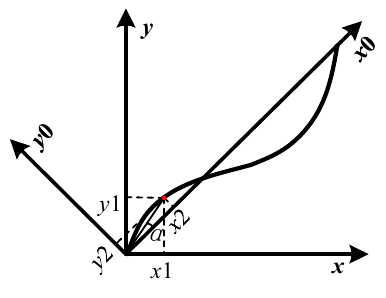
Figure 6. The conversion between coordinate C 1 and C 2.